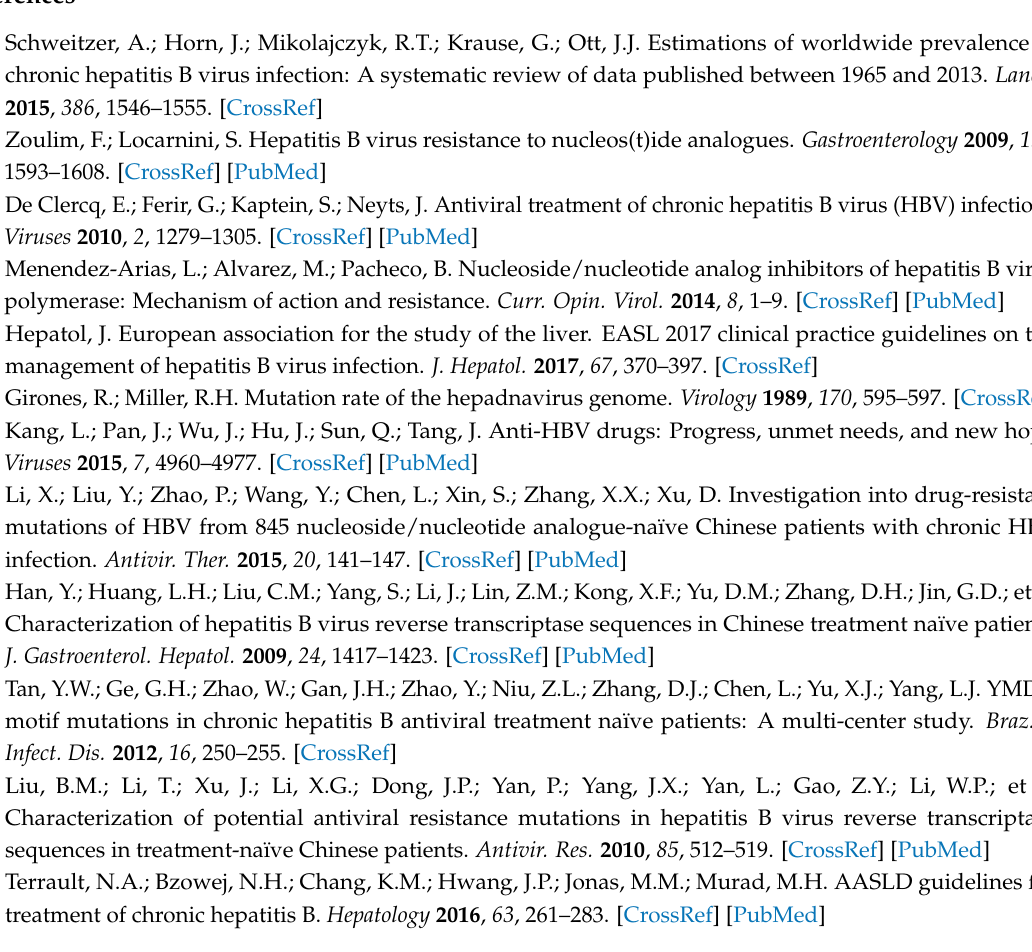
Figure S1: HBV genotypes identified in this study and their geographical distributions; Figure S2: The HBV sequences with recombinant genotypes found in this study; Figure S3: The distribution of HBV RT sequences with NUCr-related substitutions in different countries; Table S1: Summary of the relevant information of HBV sequences used in this